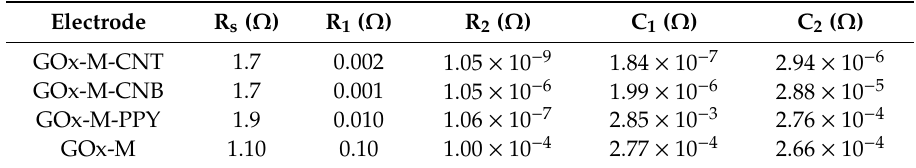
Table 2. Impedance data for the bioanode. Electrode